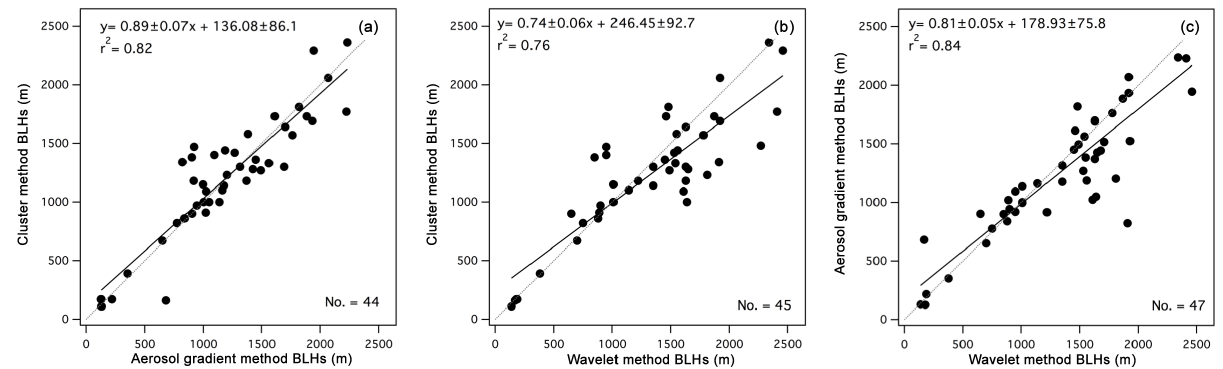
Figure 7. Intercomparison of all methods using cloud-free profiles. One-to-one line in dashed grey and linear regression lines in solid black.